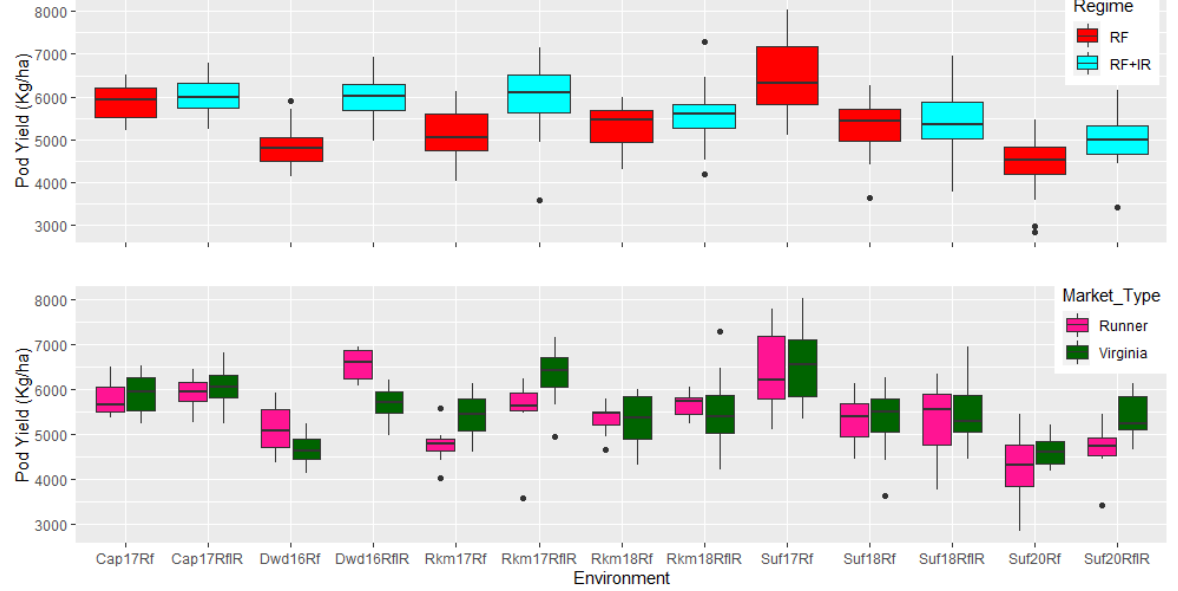
Figure 3. Boxplot for the effect of water regime and market type on yield of 5 Virginia and runner peanut cultivars in 13 environments. Each plot indicates total range, interquartile range (box), and median (line). Environment names are coded and the first three letters indicate location: Cap, Capron, VA; Dwd, Dinwiddie, VA; RM, Rocky Mount, NC; Suf, Suffolk, VA; two digits indicate year of the trial; 16 for 2016, 17 for 2017, 18 for 2018, 20 for 2020; and the last letters Rf and RfIR for water regime: Rf, rainfed, RfIR, rainfed plus irrigated. The upper part of the figure shows the effect of water regime and the lower part the effect of market type.